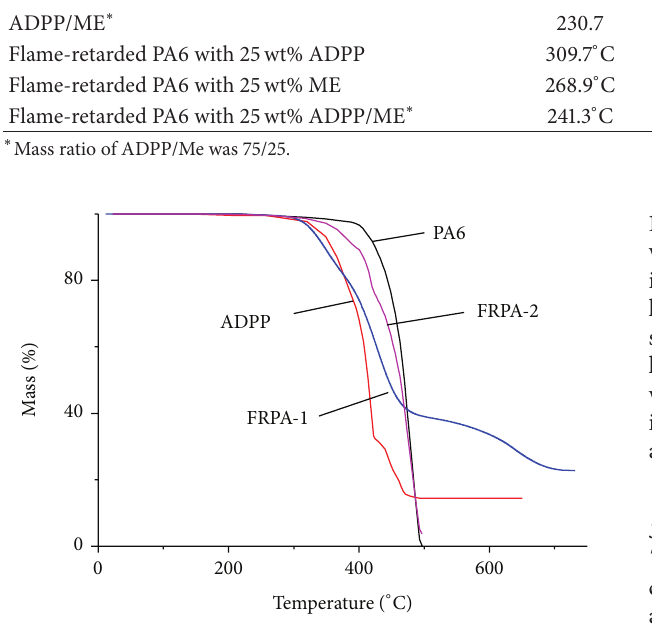
Figure 5: TG of the flame-retarded PA6 with ADPP. FRPA-1: flame- retarded PA6 with 25 wt% of ADPP; FRPA-2: additive curve of 75% PA6 and 25% ADPP.